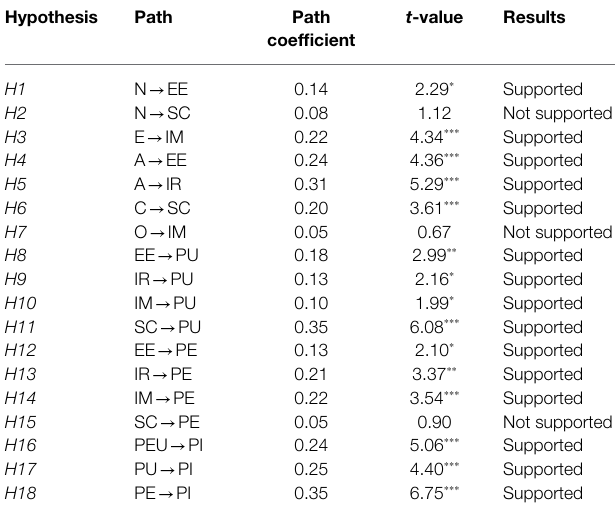
TABLE 9 | Path analysis and hypothesis testing results.